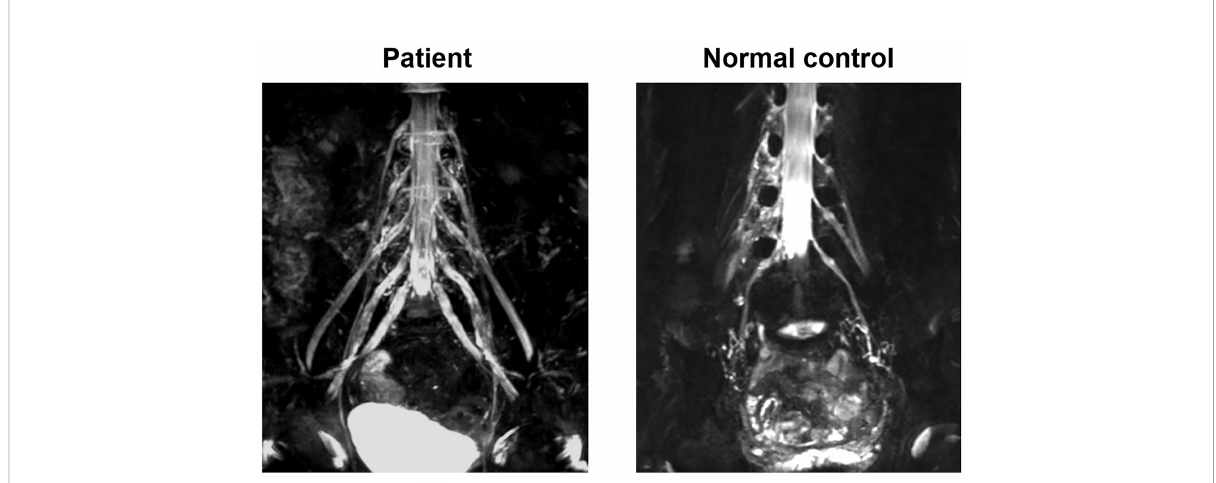
FIGURE 1 MRI neurography with enhancement imaging of lumbosacral spinal roots and plexuses. The patient showed marked symmetric hypertrophy and increased signal intensity in lumbosacral roots and plexuses comparing with normal